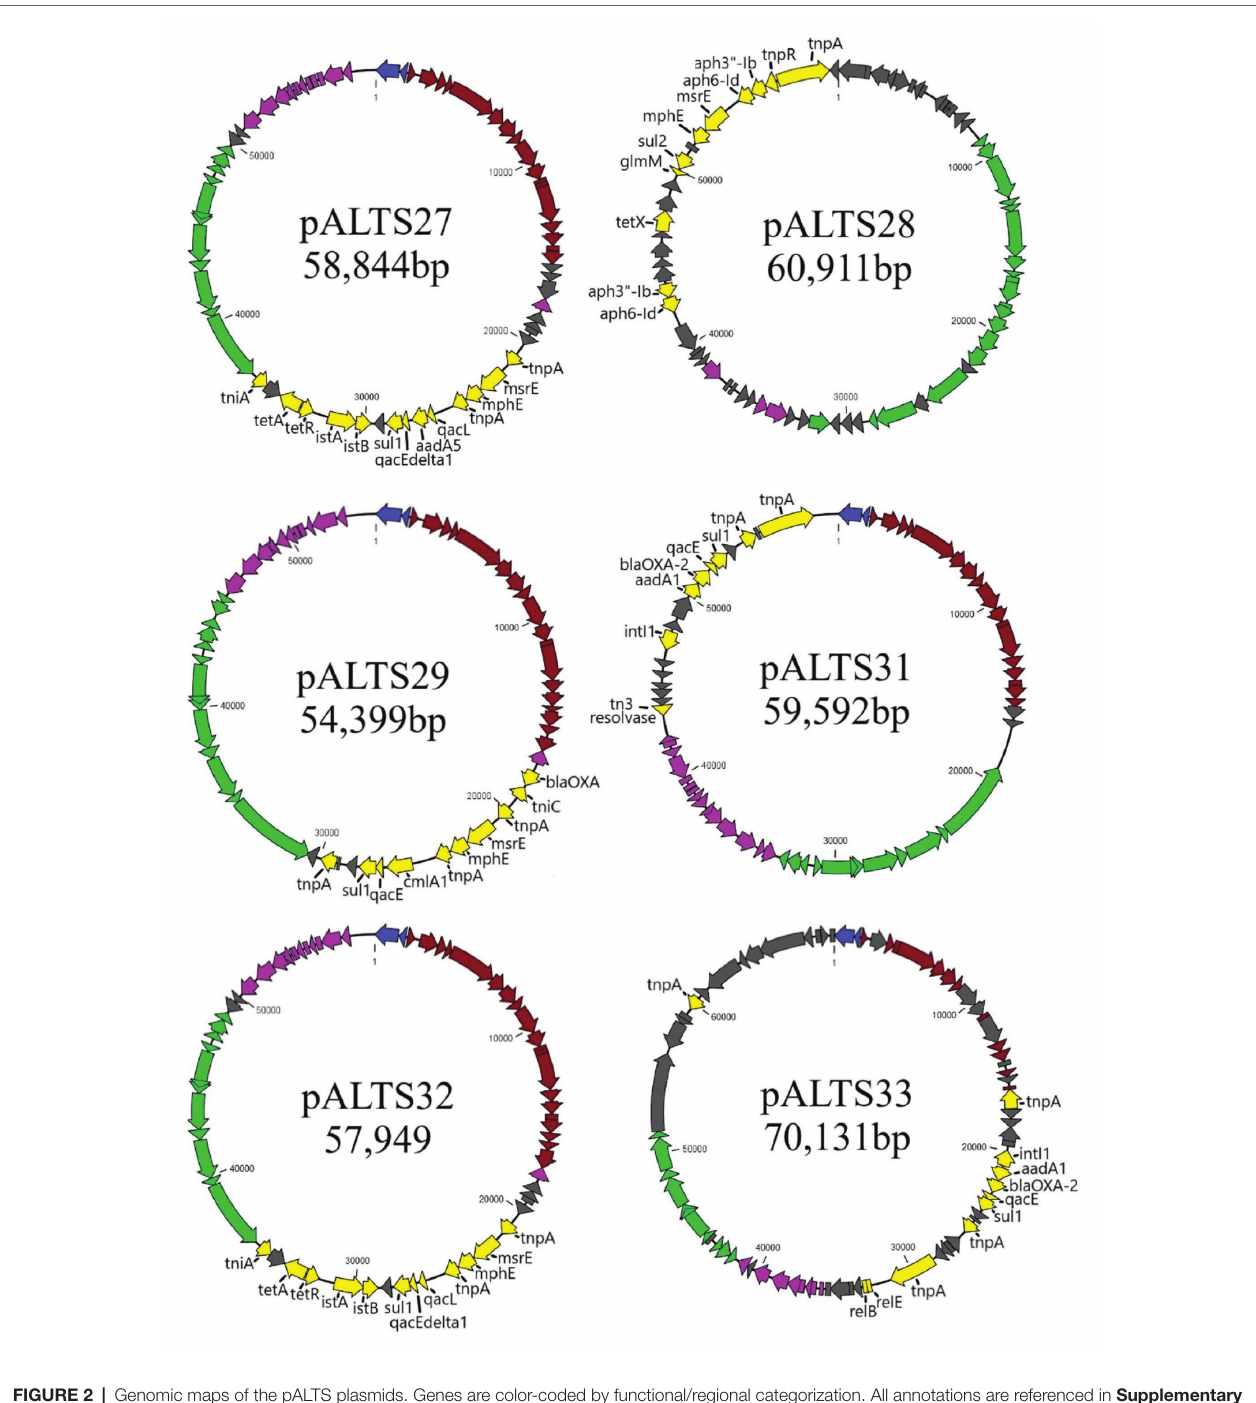
FIGURE 2 | Genomic maps of the pALTS plasmids. Genes are color-coded by functional/regional categorization. All annotations are referenced in Supplementary Table S1 . Replication, Mating Pair Formation, DNA Transfer, Maintenance and Control, Accessory, and